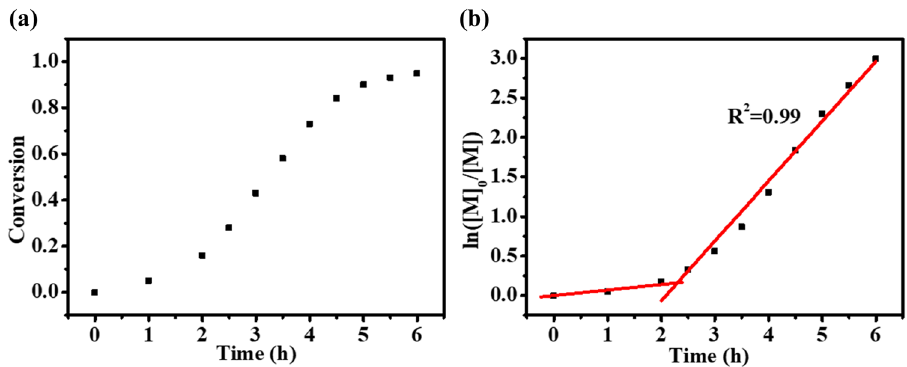
Figure 2: ( a ) Polymerization kinetics of dispersion polymerization of HDFA mediated by PDMA 21 at a 20% solids content in ethanol at 60°C and ( b ) plot of the pseudo - fi rst - order kinetics of the polymerization. ABVN/PDMA 21 /HDFA =